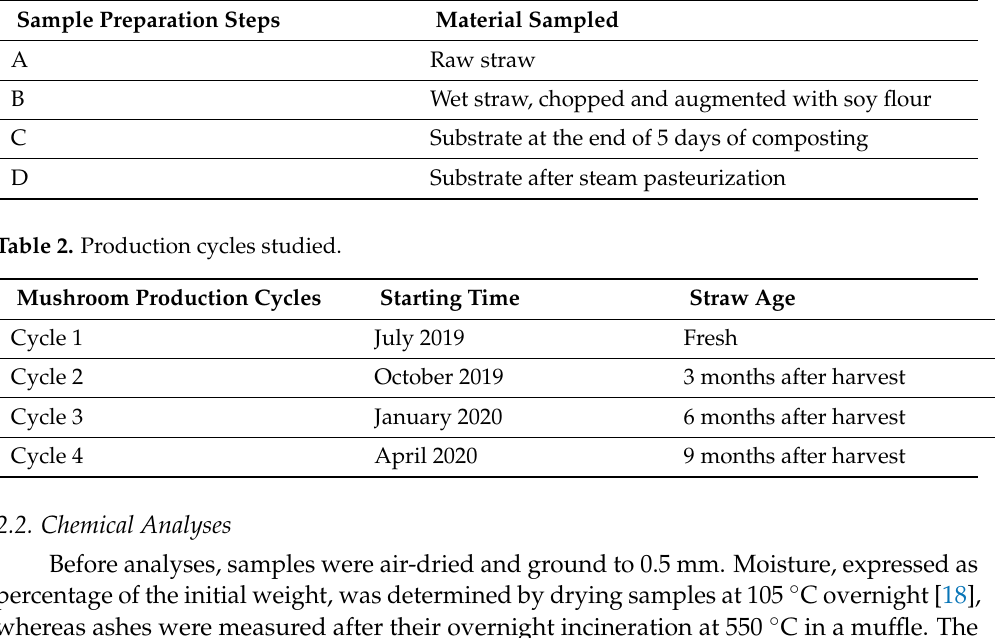
Figure 1. Substrate preparation for mushroom growth: ( a ) short composting process; ( b ) steam pasteurization; ( c ) substrate inoculation; ( d ) bale preparation; ( e ) Pleurotus ostreatus fruitbody. Table 1. Sample preparation steps during substrate preparation.